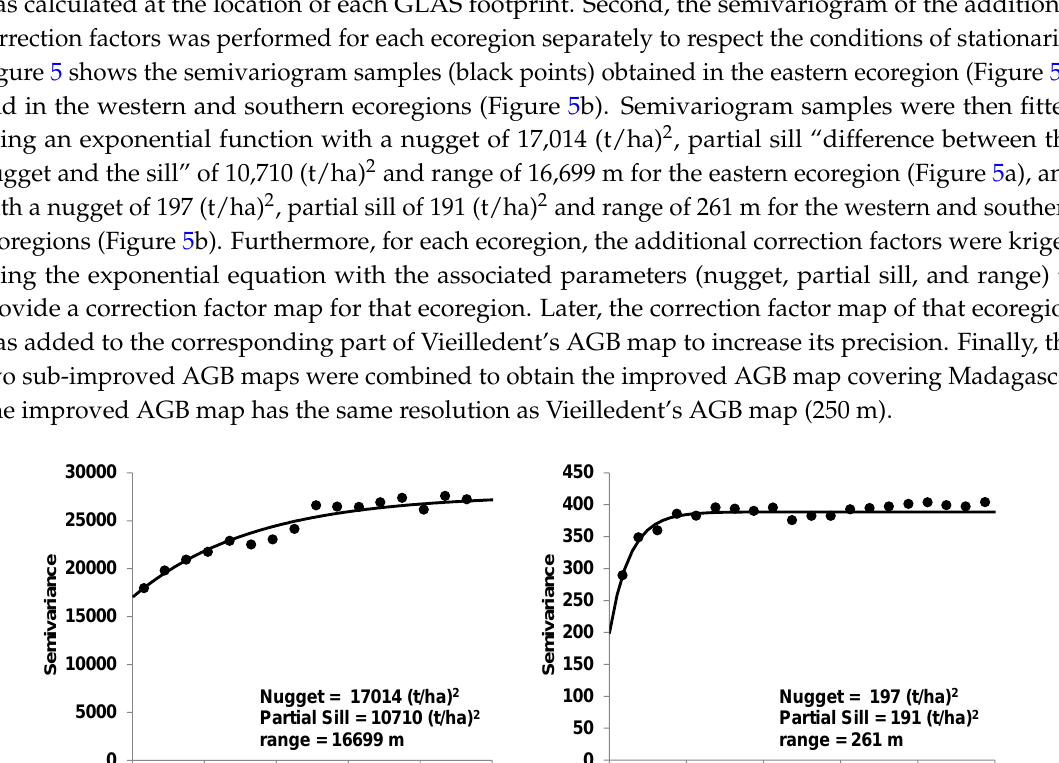
(b) Figure 6. ( a ) Vieilledent’s AGB map as a function in situ AGB; ( b ) the improved AGB map as a function of in situ AGB. N is the number of samples used for validation. In addition, statistics were calculated separately for in situ AGB lower and higher than 400 t/ha. For in situ AGB lower than 400 t/ha, the precision of the improved AGB map was better than the